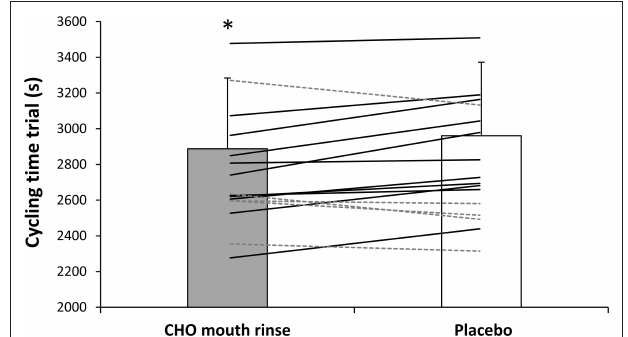
FIGURE 2 | Time employed to complete the cycling time trial with carbohydrate mouth rinsing or with placebo mouth rinsing. Solid lines represent participants with lower times in the carbohydrate mouth rinsing protocol vs. placebo. Dashed lines represent participants with higher times in the carbohydrate mouth rinsing protocol vs. placebo. *Different from placebo at P < 0.05.